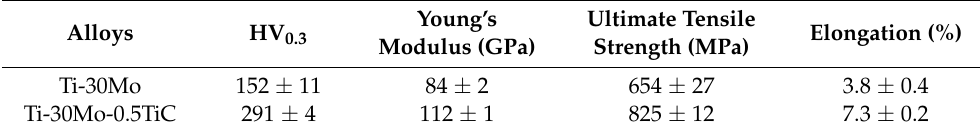
Table 2. Mechanical properties of Ti-30Mo-nTiC alloys at room temperature. Alloys HV 0.3